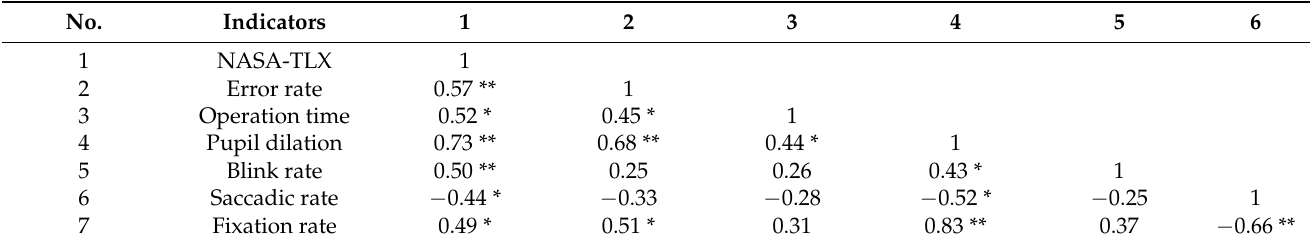
Table 7. Correlation analysis under the low workload.